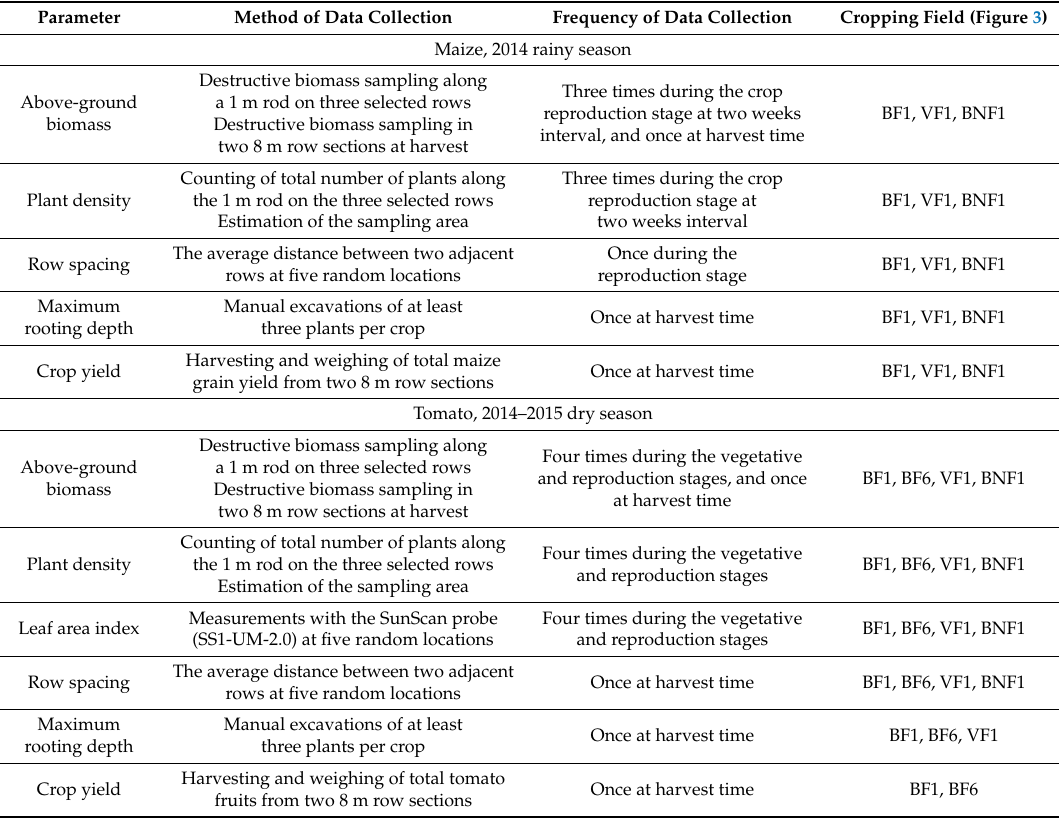
Table A3. Summary of crop growth and yield parameters and details of their measurements for each study